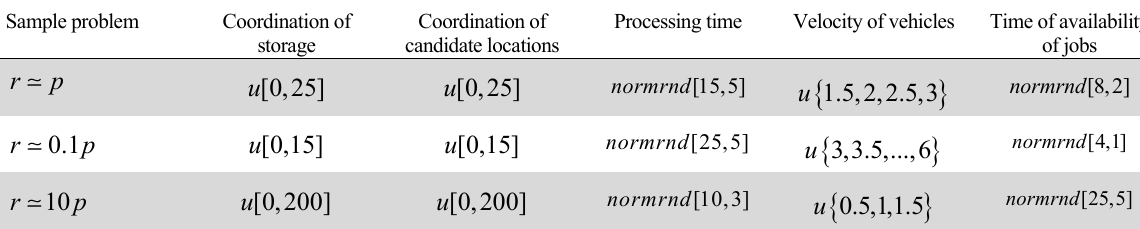
Input data used for testing different instances